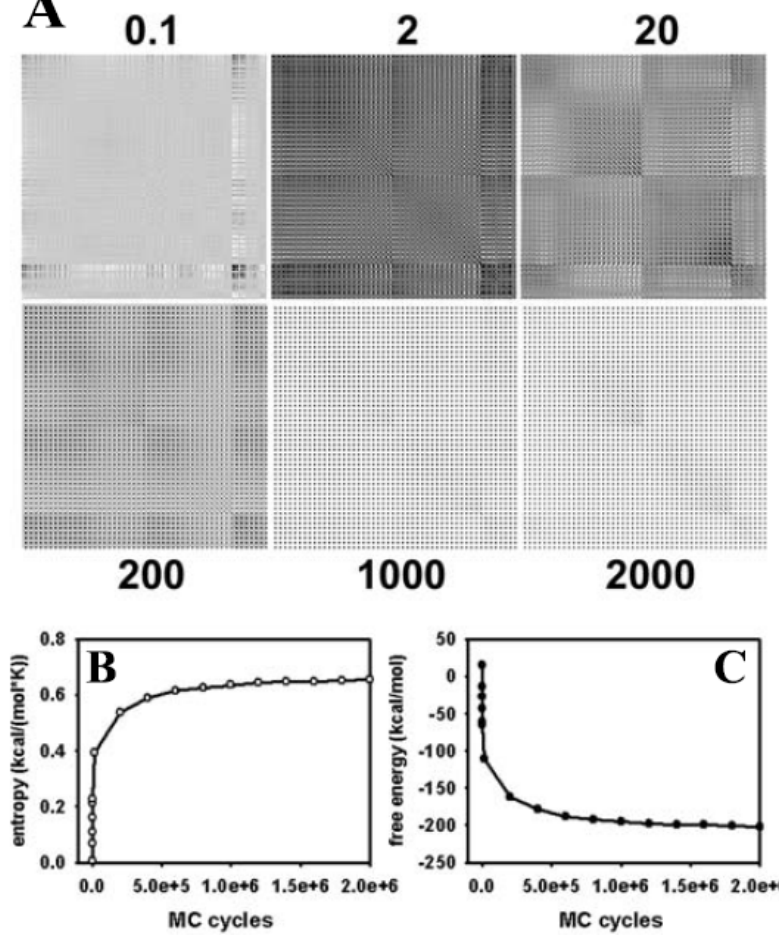
Figure 3. Covariance, conformational entropy and free energy of a single DPPC molecule. ( A ) from trajectories of single molecule simulations the covariance matrix of atomic positions was calculated and plotted as a 150 × 150 matrix for 100 (=0.1), 2,000 (“2”), 20,000 (“20”), 200,000 (“200”), one million (“1000”), and two million (“2000”) MC steps, respectively. Dark and light spots indicate high and low values of (co-)variances, respectively. The matrix values do not change grossly after 1 million MC steps with low off-diagonal values ( i.e. , covariances). This indicates equilibration of the structural sampling and absence of significant correlations of fluctuations of adjacent atoms in the DPPC molecule; ( B ) the conformational entropy was calculated from the mass-weighted covariance matrix after a given number of MC steps, as described in the text; ( C ) the conformational free energy was calculated as F = E − T · S with E and S being the conformational (internal) energy and entropy, respectively. The temperature of the simulation was 323 K ( i.e. , 50